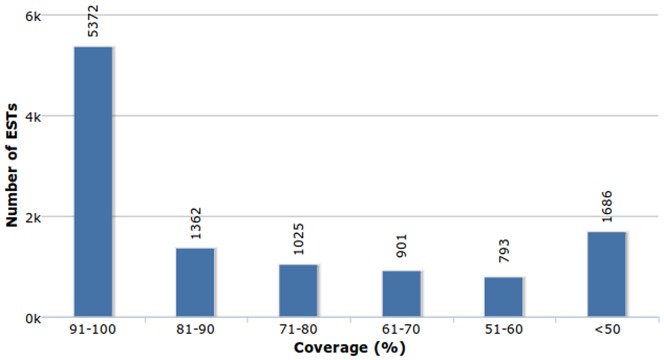
Coverage distribution of NCBI C. longa ESTs matched against representative transcripts using BLAST.